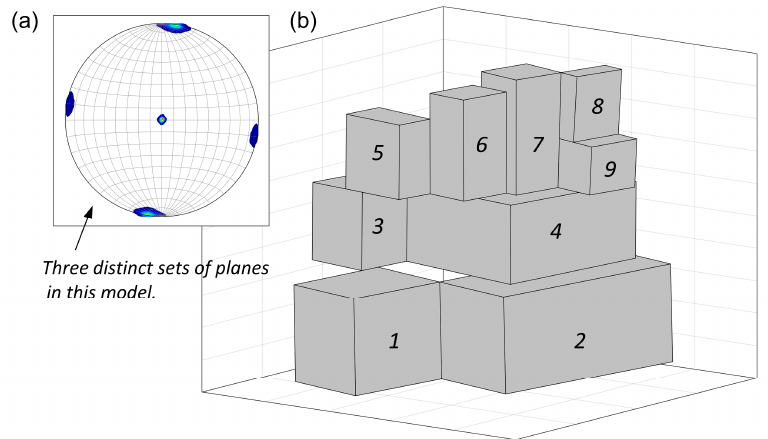
Figure 11. ( a ) The stereographic projection of three sets of planes (i.e., equal angle net on the lower hemisphere). ( b ) The extraction of blocks of the synthetic box model with all blocks labeled.